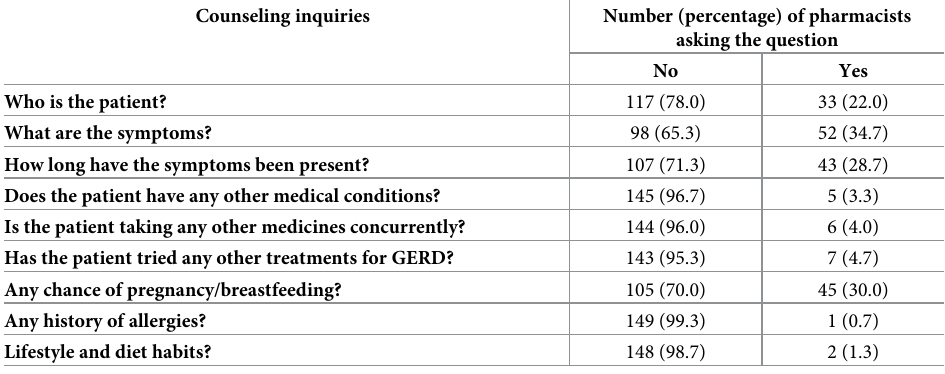
Table 3. Counseling practice across community pharmacists (n =